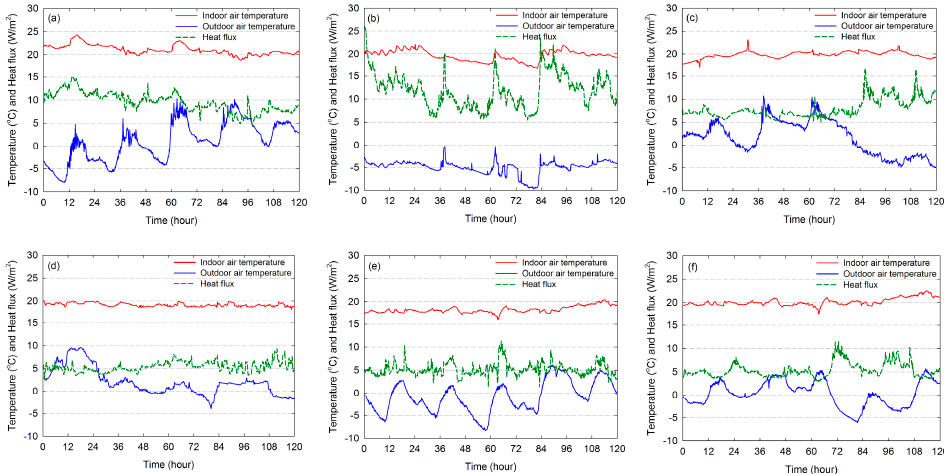
Figure 3. Measured heat flux at the indoor surface and indoor and outdoor air temperatures: ( a ) Case 1; ( b ) Case 2; ( c ) Case 3; ( d ) Case 4; ( e ) Case 5; ( f ) Case 6.